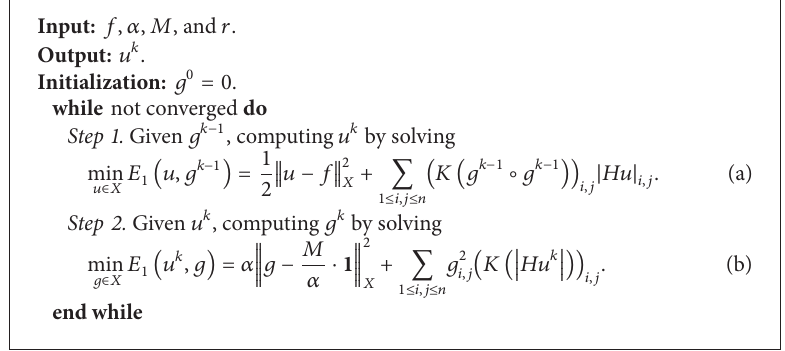
Algorithm 1: The alternating minimization method for solving Model 1.